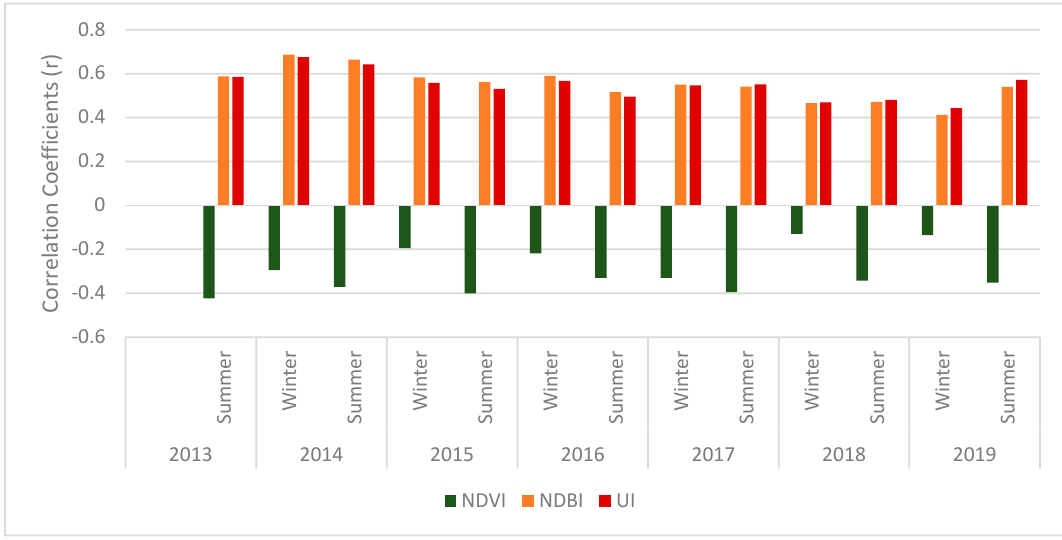
Figure 9. Spearman correlation test between LST and NDVI, NDBI, and UI. P < 0.01 for all.